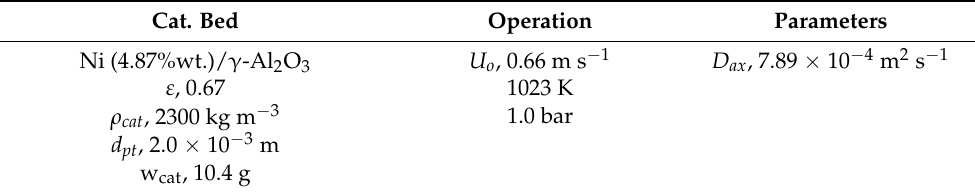
Table 4. Characteristics of the catalytic system and operating conditions . Cat. Bed